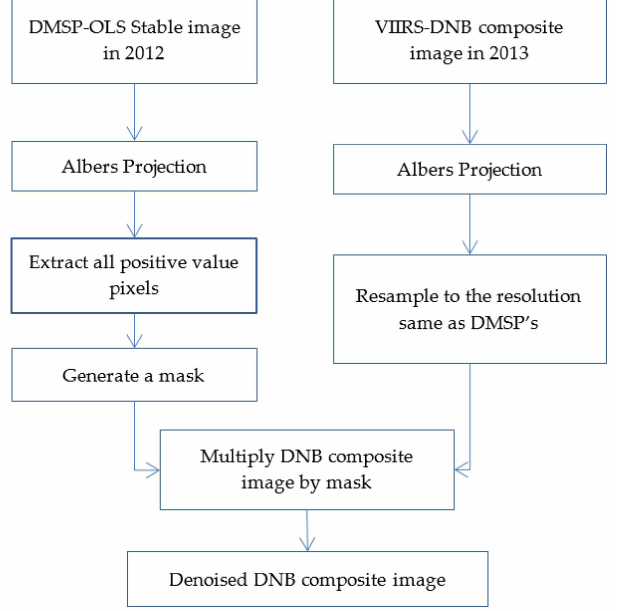
Figure 2. Flow chart of the noise masking method (NMM) in removing background noise for DNB composite